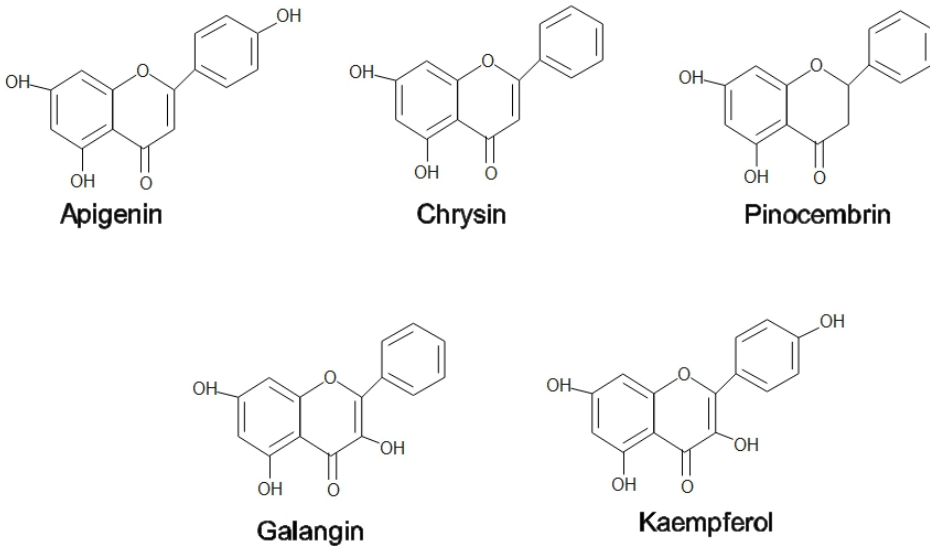
Figure 1. Flavonoids compound in honey and propolis.